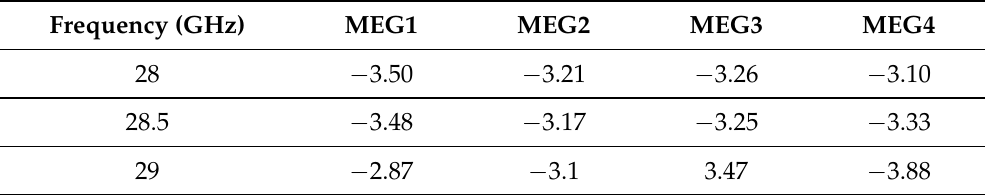
Table 1. Mean effective gain of the proposed MIMO antenna.